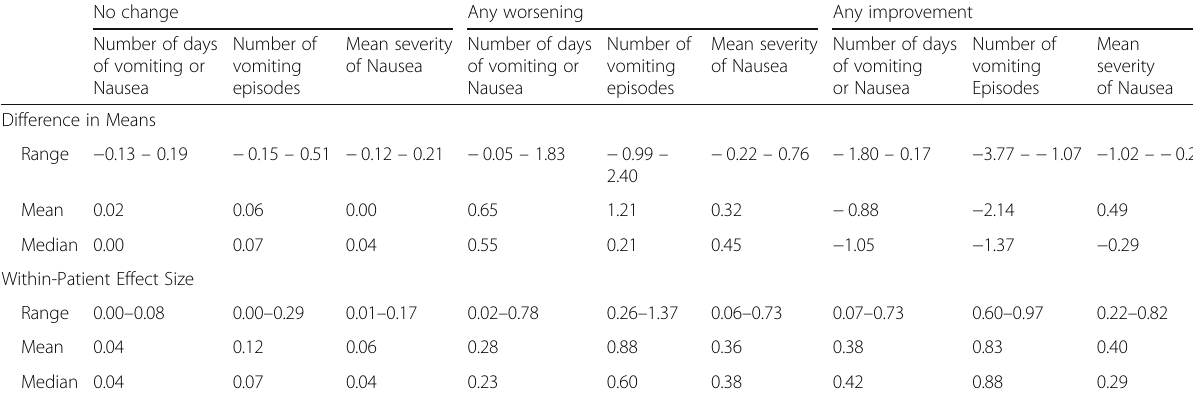
Table 7 Summary of results of ability to detect change of NVSA © scores with the sPGA and effect size No change Any worsening